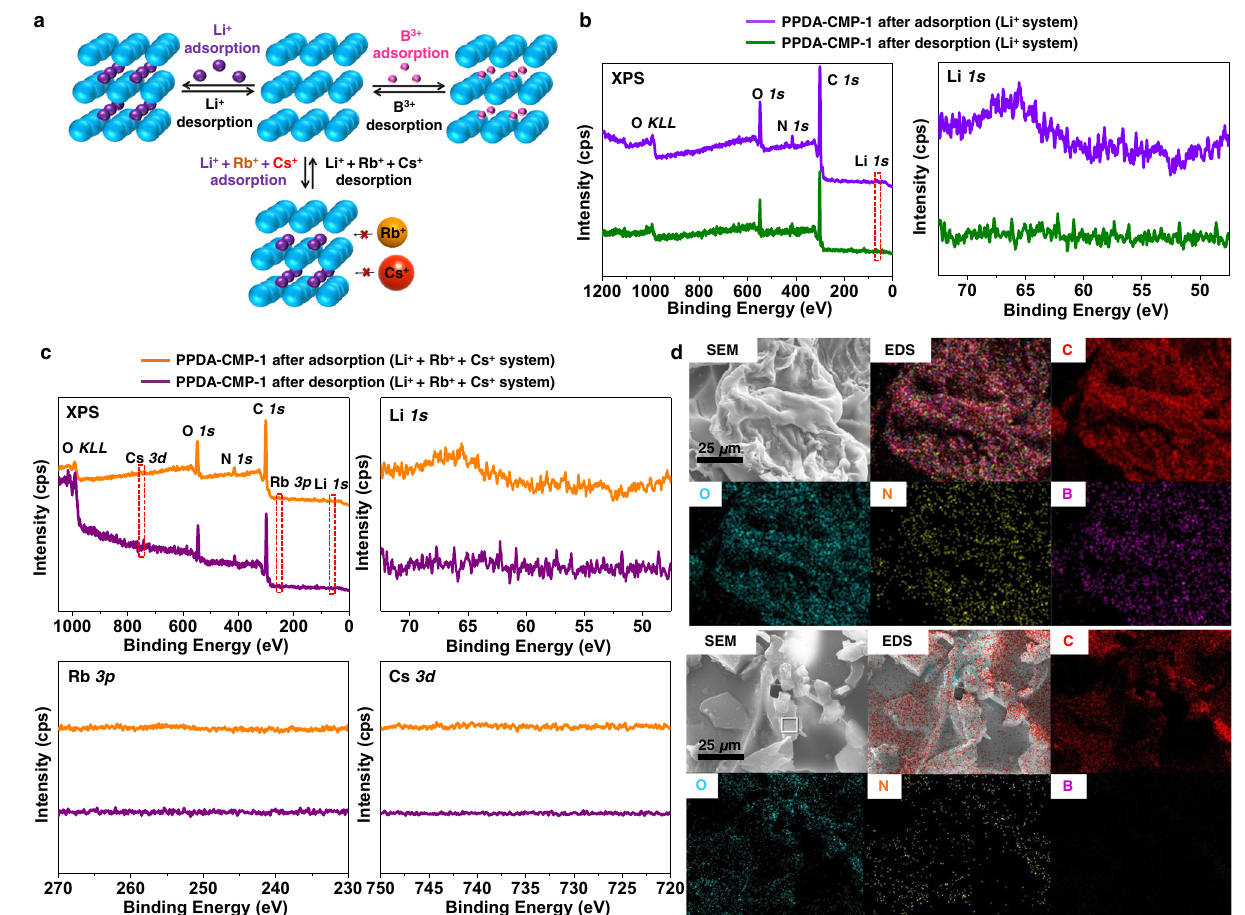
Fig. 3 | Metal ion adsorption-desorption in PPDA-CMP. a Schematic illustration of adsorption-desorption of Li + (left) and B 3+ (right) in PPDA-CMP. Li + is selectively adsorbed from a mixture of Li + , Rb + and Cs + in PPDA-CMP-1 (bottom). b Full and Li 1s XPS spectra of PPDA-CMP-1 after Li + adsorption (purple lines) and desorption (greenlines)forthepureLi + system (Table 2,entry1). c Full,Li 1s , Rb 3p ,and Cs 3d XPS spectra of PPDA-CMP-1 after metal ion adsorption (orange lines) and